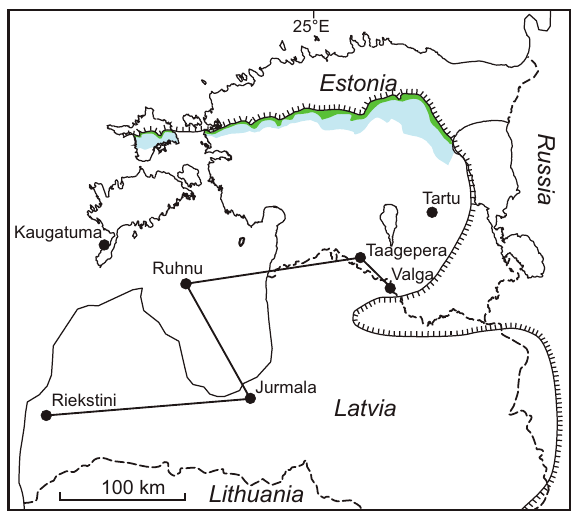
Fig. 1. The study area, sections addressed in the text and outcrop belts of the Porkuni (green) and Juuru (blue) regional stages. Based on Gailīte et al. (1967), Birkis et al. (1976), Kaljo & Jürgenson (1977), Ulst et al. (1982), Hints & Meidla (1997) and Nestor